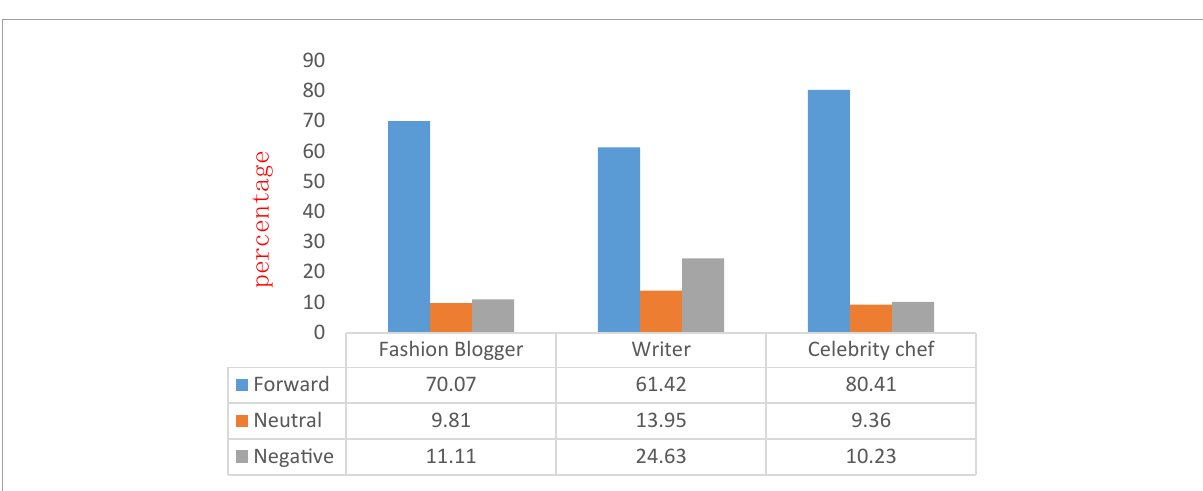
of the degree word, D ( d ) = Q d i . γ indicates the positional relationship between the negative word and the degree word, when the negative word and the degree word exist at the same time and the negative word is before the degree word γ = 1, otherwise γ =